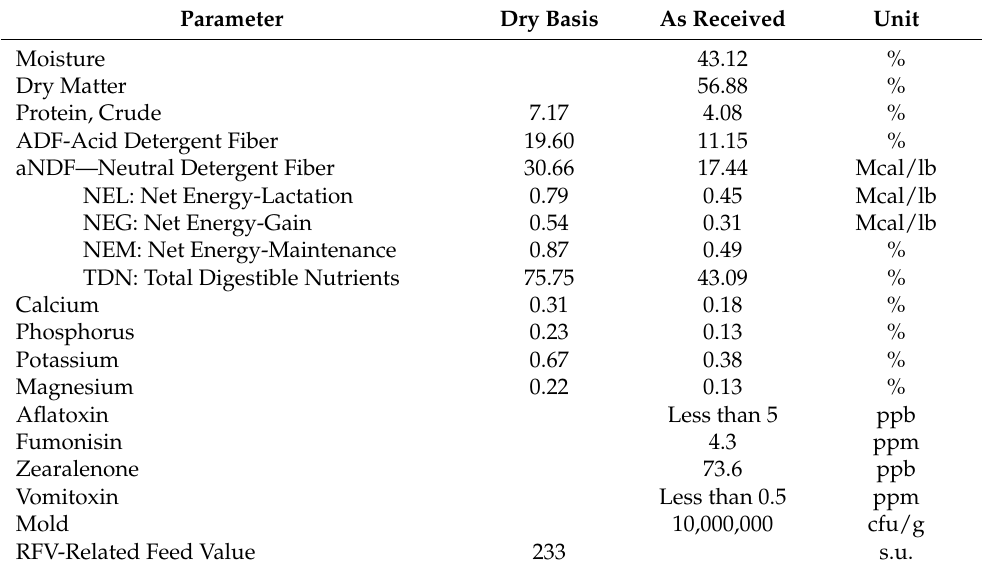
Table 1. Feed analysis performed by SDK Laboratories. SDK Laboratories NOTE: Should discontinue feeding due to high mold count or dilute 1:3 with “clean feed” and feed only to non-pregnant animals or animals not under